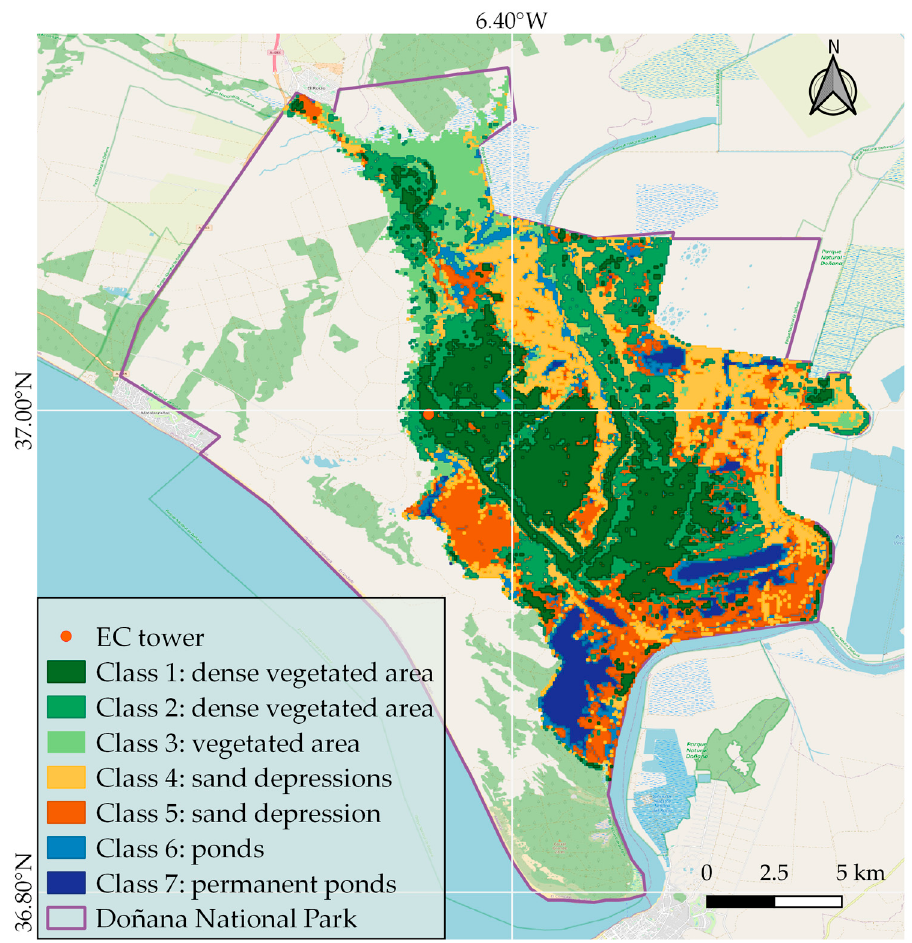
Figure 10. Vegetation classification maps showing the seven classed identified by k-means algorithm implemented in Google Earth Engine API and ee. python package using a Sentinel-2 L2A mean composite image from the 1 October 2020 to the 31 May 2021. Class 1 and 2 correspond to the dense vegetated area, mainly dominated by the Cyperus rotundus, and the Cyperus rotundus and Sarcocornietea fruticosae plants, respectively. Class 3 is a vegetated area mainly dominated by the Cyperus rotundus . Class 4 and 5 are sand depression areas mainly characterized by salt marshes and shrubs and salt marshes, respectively. Class 6 and 7 correspond to ponds, temporarily and permanently flooded areas, respectively.